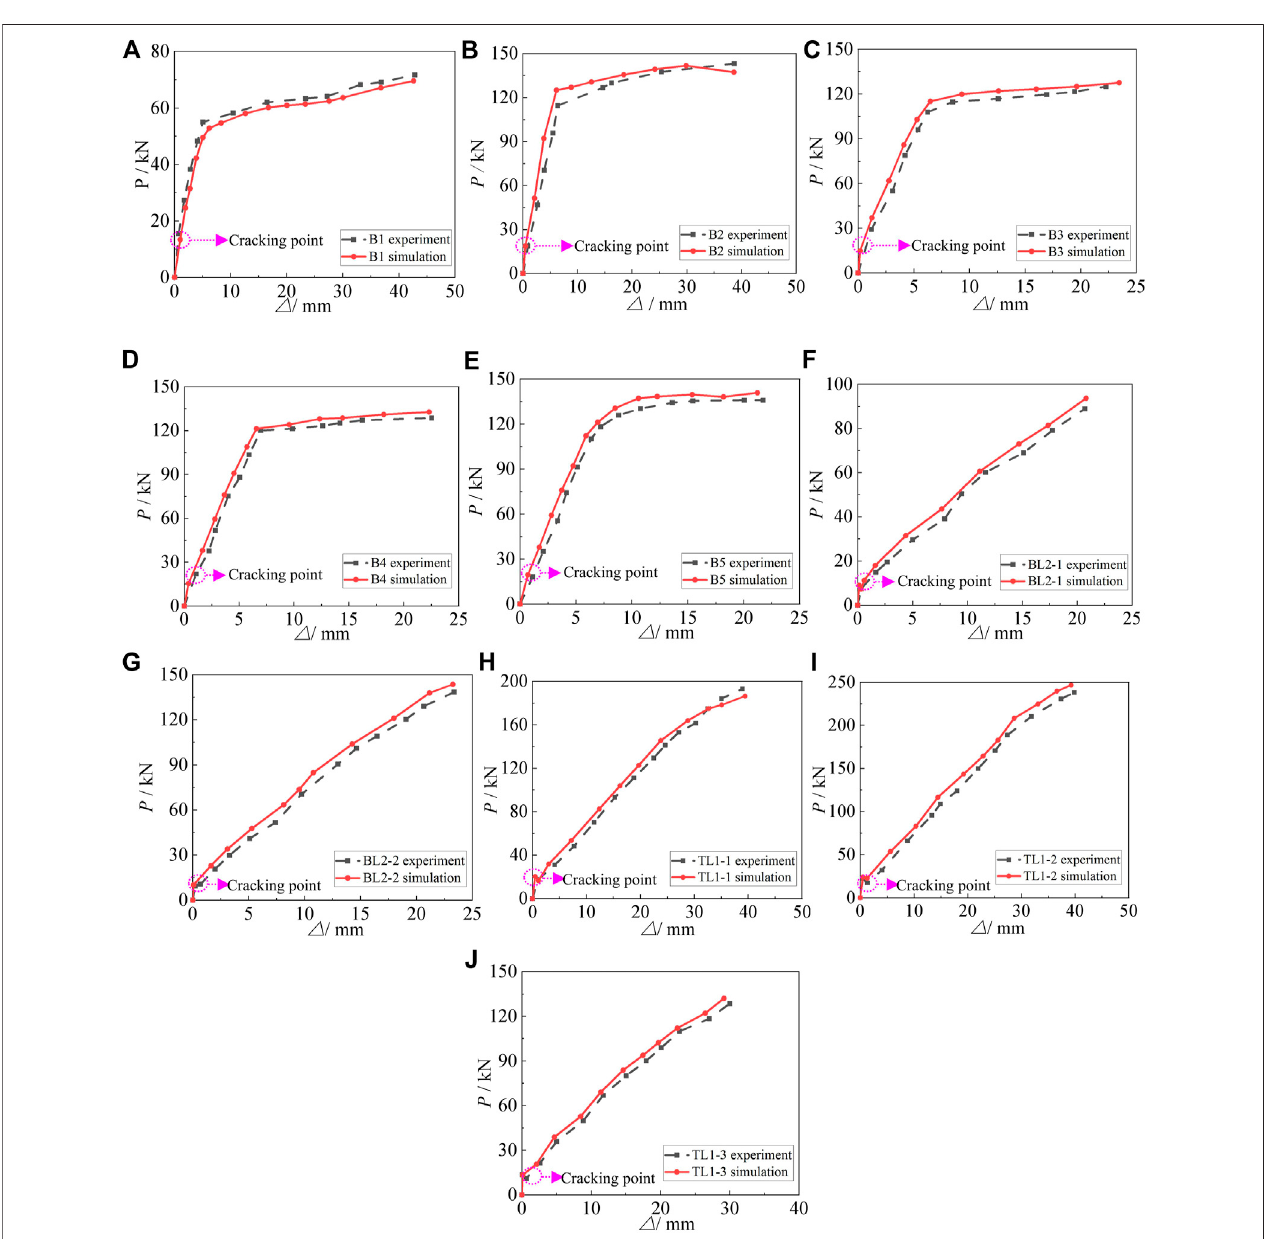
FIGURE 6 | Comparison of simulation curves and experiment curves: (A) B1; (B) B2; (C) B3; (D) B4; (E) B5; (F) BL2-1; (G) BL2-2; (H) TL1-1; (I) TL1-2; (J) TL1-3.